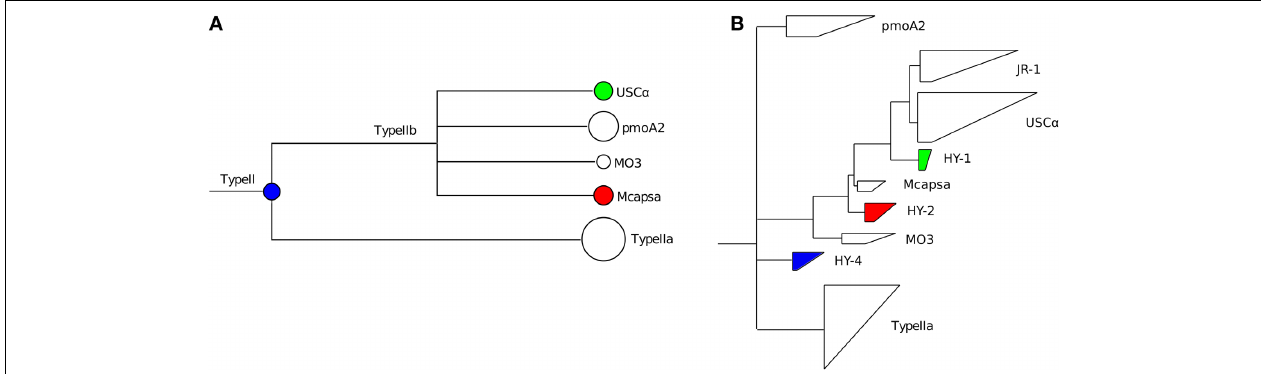
FIGURE 4 | Analysis of selected Type II pmoA sequences from the HYa-1 sample (Deng et al., 2013). The sequences chosen for analysis are color-coded in the partial MEGAN tree (A) . The USC α and Methylocapsa -assigned sequences were selected since the alignments showed conserved mismatches to the reference database (as shown for USC α sequences in Figure 3C ). The sequences were imported